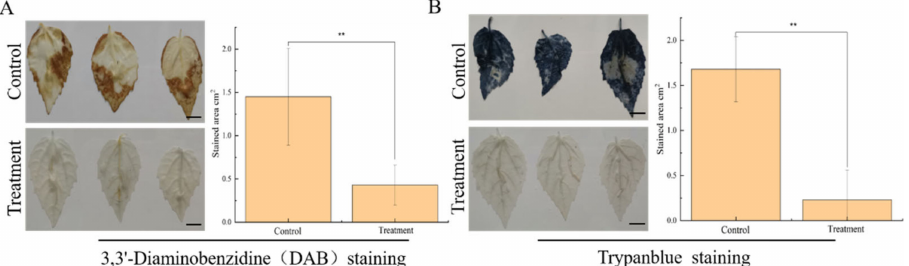
Figure 3. DAB and Trypan blue staining result. The results of Pdpap poplar leaves with DAB ( A ) and Trypan blue ( B ) 20 days after inoculation of treatment statistical analysis of DAB and trypan blue using Image J software; Biology repeated three times; ** indicate significant differences between the groups (ANOVA, ** < 0.01); Architect’s scale is 1